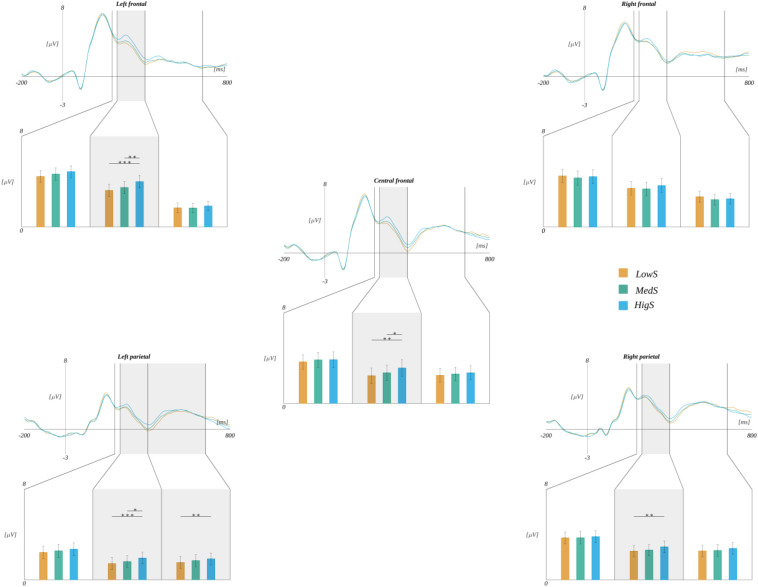
Interaction between regions of interest and subjective significance. In each panel, the upper plot shows grand average ERP traces for each level of subjective significance, whilst the lower bar plot displays the average amplitude within each time-window for each level of subjective significance. Error bars mark SEM. Horizontal lines with asterisks mark significant differences (*p < 0.05, **p < 0.01, ***p < 0.001). Time-windows with significant effects are marked with gray shadings.